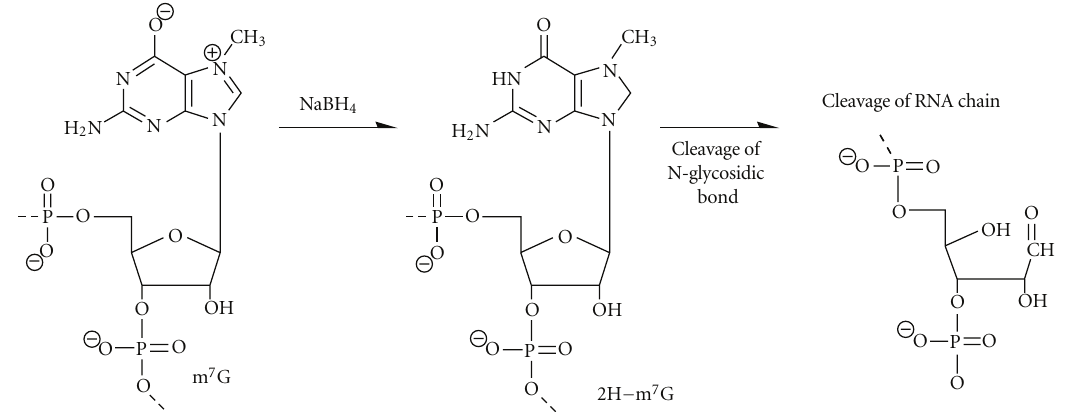
Figure 3: Sodium borohydride (NaBH 4 ) reduction of m 7 G in RNA. Reduction of m 7 G leads to formation of abasic site in RNA followed by the cleavage of the RNA chain by β